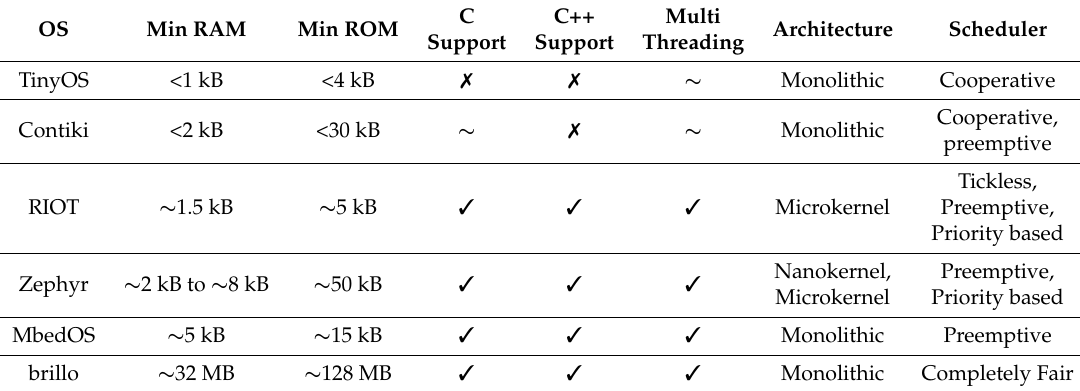
Table 1. Overview of IoT